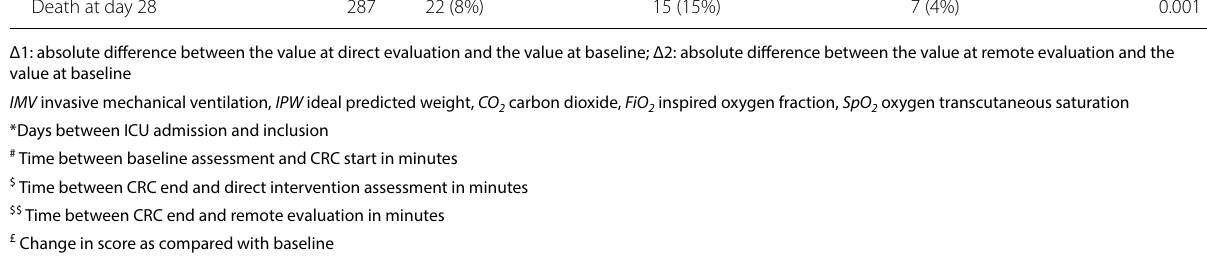
Table 4 Factors associated with response to corporeal rehabilitation care in critically ill patients